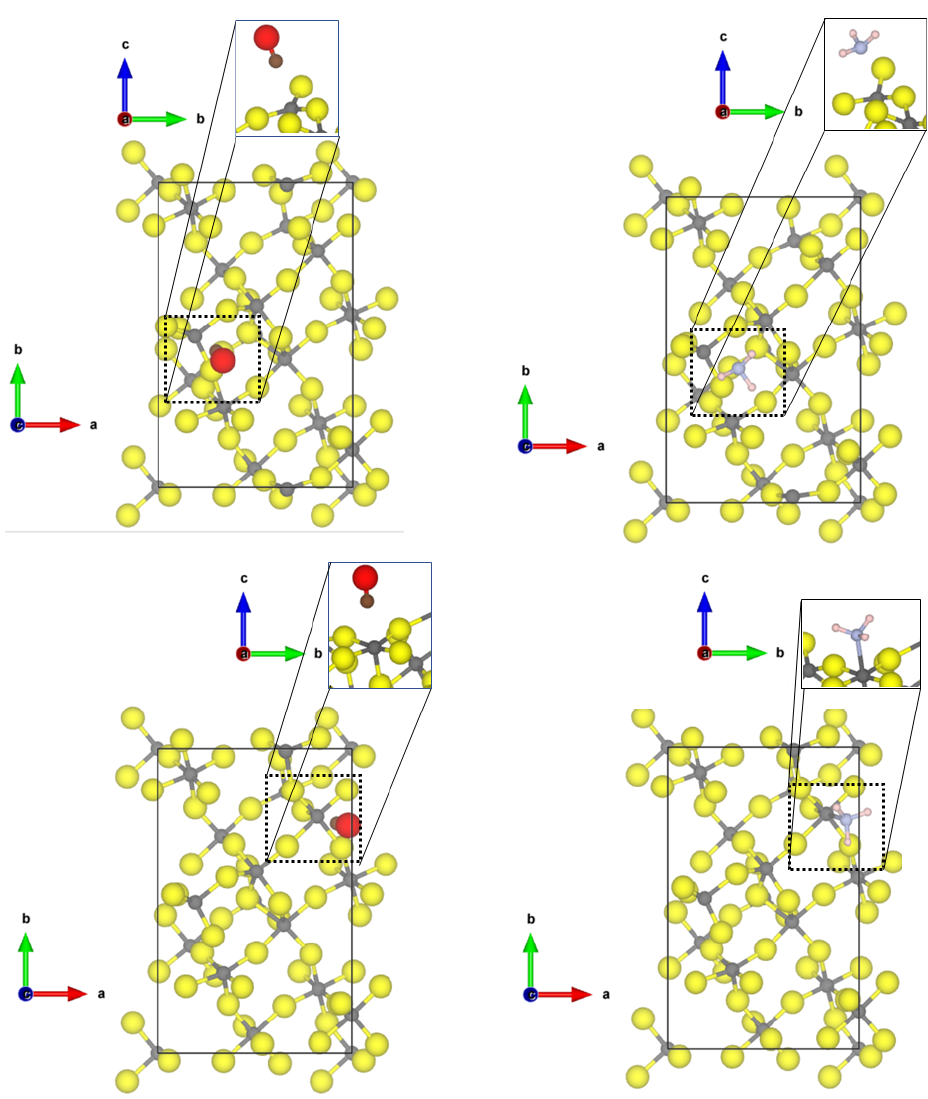
Figure 2. PBE-D3(BJ) optimized structures of the probe molecules CO ( upper row ) and NH 3 ( lower row ) on the 1 × 1 α -AlF 3 -(11¯22) surface; left = tetragonal site; right = square-pyramidal site yel- low = fluorine, grey = aluminium, brown = carbon, red = oxygen, blue = nitrogen, pink =